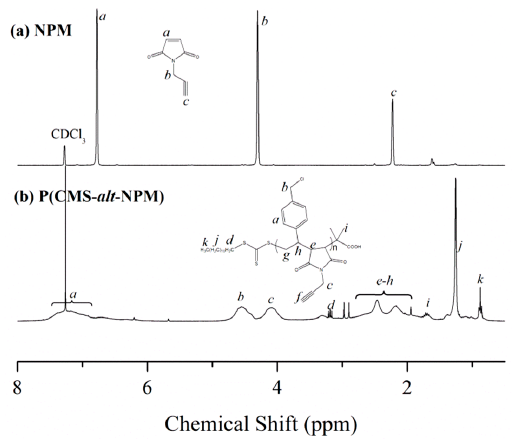
Figure 2. 1 H NMR spectra of ( a ) NPM and ( b ) P(CMS- alt -NPM)1 in CDCl 3 .